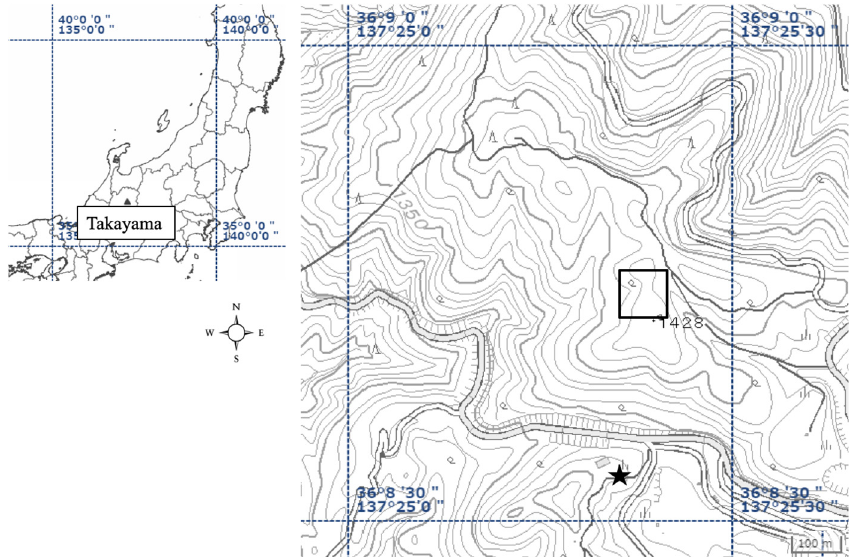
Figure 1. Location of the study site at Takayama Forest Research Station ( ★ ). A square indicates a permanent plot (100 m × 100 m). Map is from the Geospatial Information Authority of Japan.